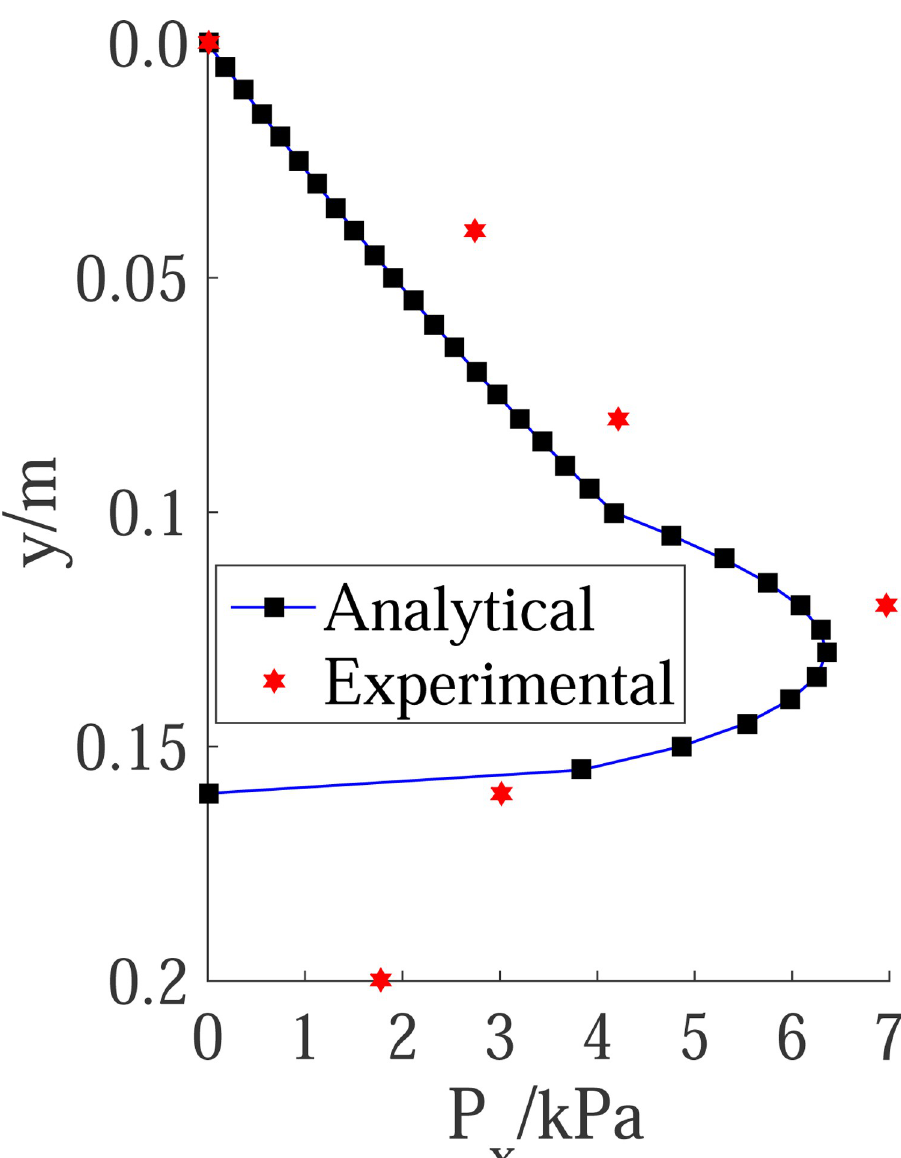
Fig 19. Comparison of passive pressure distribution with model test